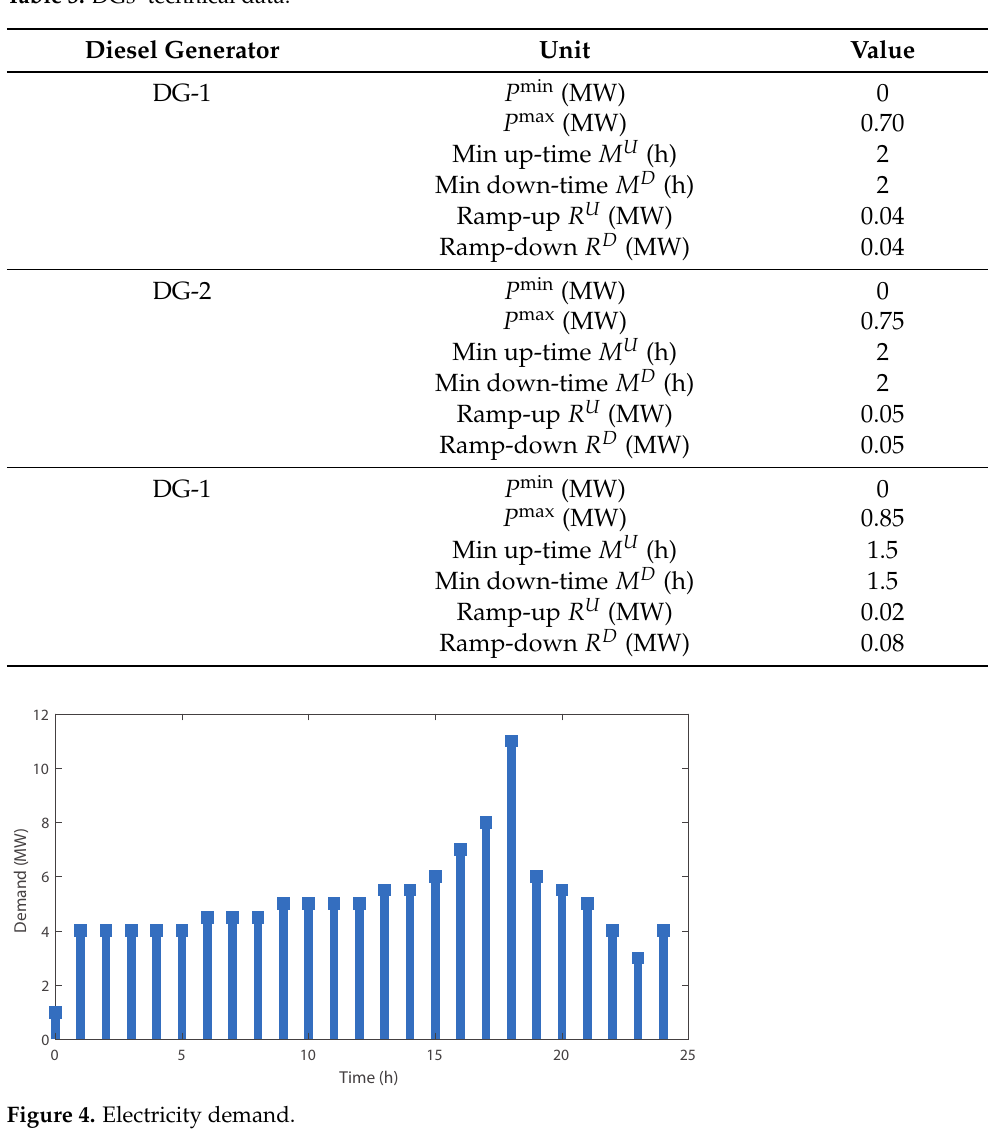
Table 3. DGs’ technical data.